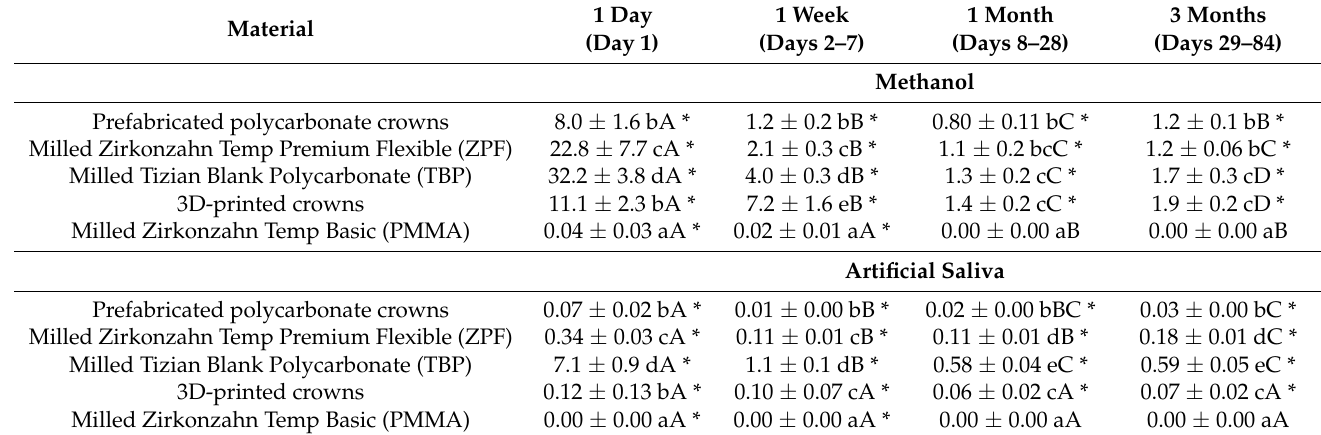
Table 1. The average daily release of BPA in µ g/g (Mean ± SD).